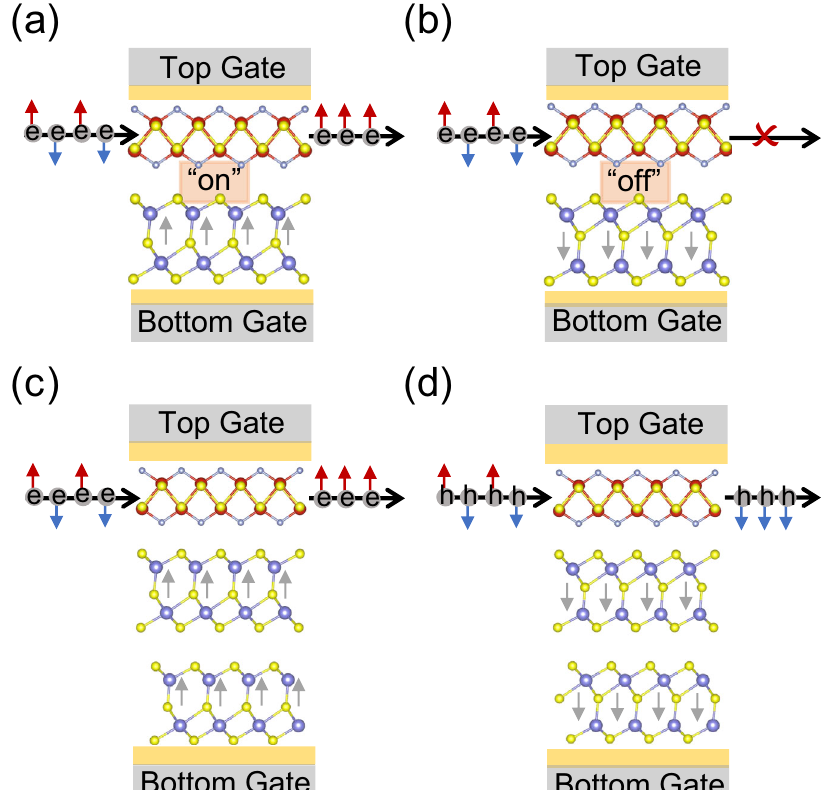
Fig. 6 Two types of spin FETs. a , b Atom-thick multiferroic memory based on the VSeF/Al 2 Se 3 bilayer heterostructure, where the data writing and reading can be achieved by manipulating the ferroelectric polarization states of Al 2 Se 3 monolayer and measuring the conductivity of VSeF channel, respectively. The red and blue arrows represent carriers ’ spin-up and spin-down polarized orientations, respectively. c , d spin ’ spin-polarized orientation and carriers ’ type (electron/hole) in the fi lter based on the VSeF/biAl 2 Se 3 trilayer heterostructure, where the carriers VSeF channel depend on the ferroelectric polarization states of bilayer FE Al 2 Se 3